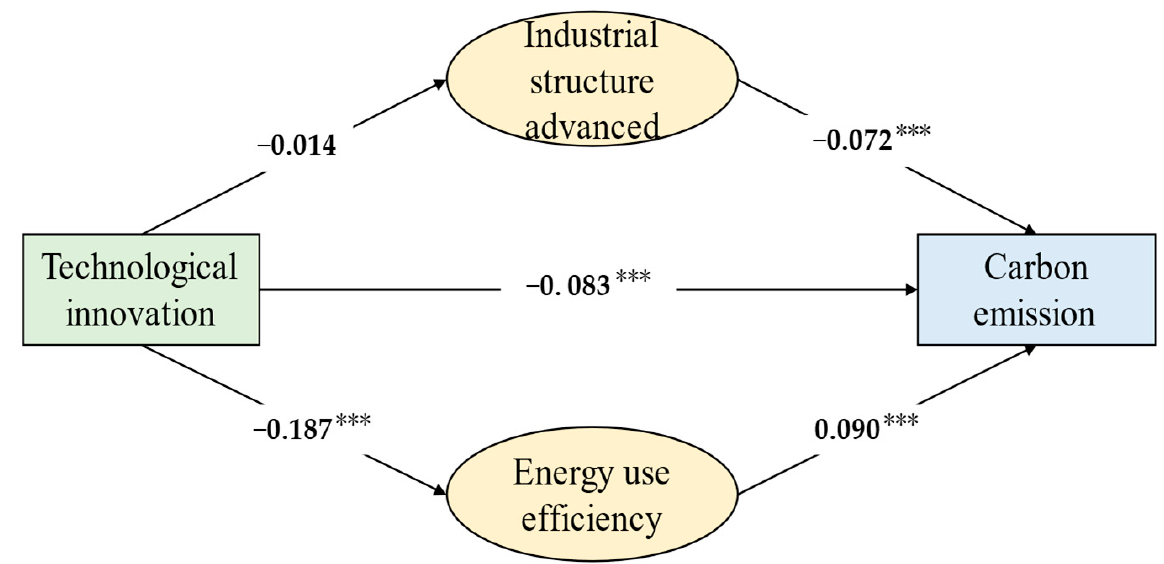
Figure 4. The impact of technology innovation on carbon emissions. Note: *: p < 0.1, **: p < 0.05, ***: p < 0.01.